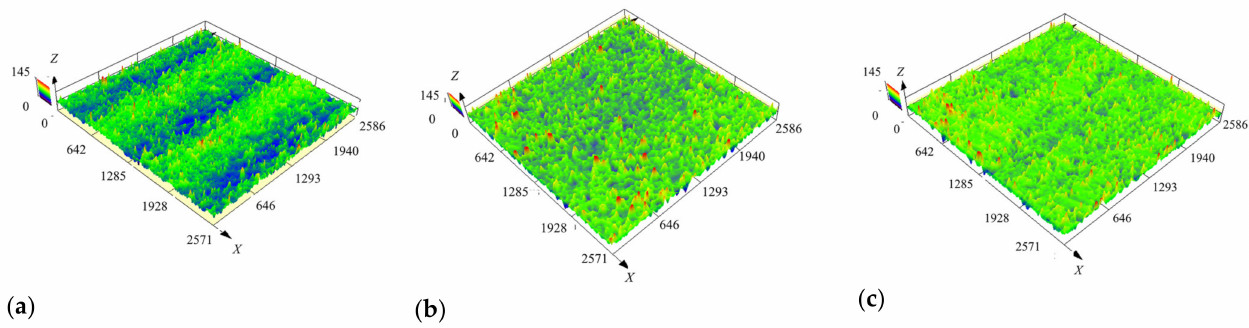
Figure 9. Three-dimensional surface topography of the steel discs after working under different loads: ( a ) the original surface; ( b ) a light load of 15 N; ( c ) a heavy load of 45